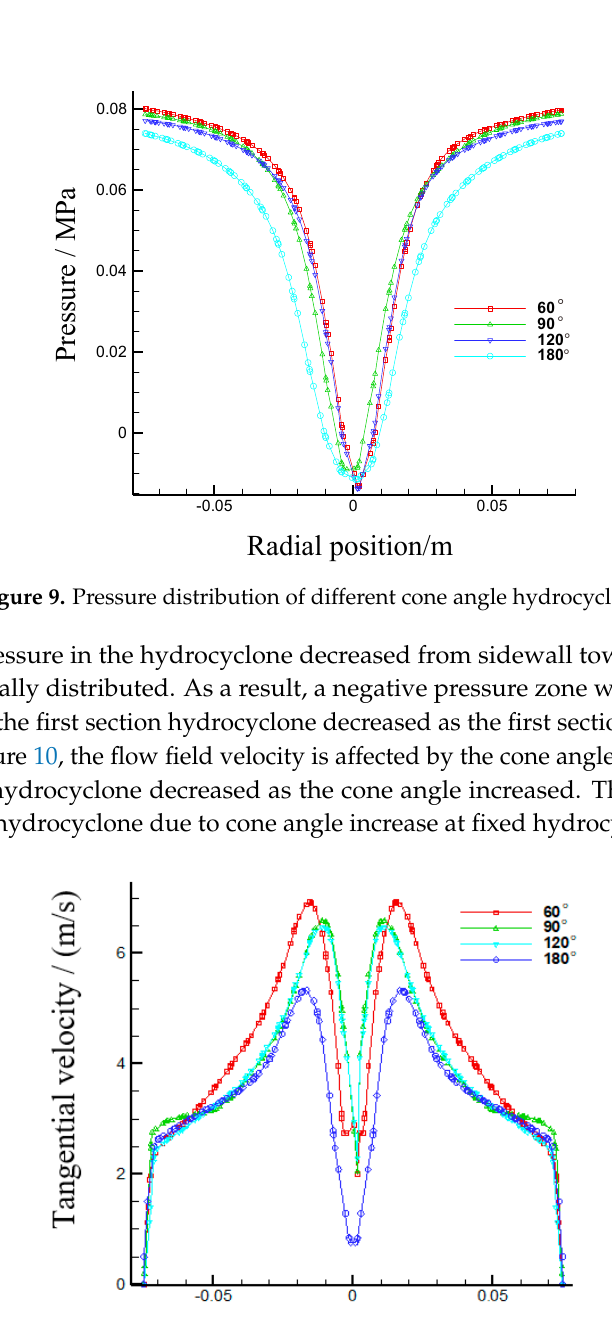
Figure 10. Tangential velocity distribution of different cone angle cyclone.